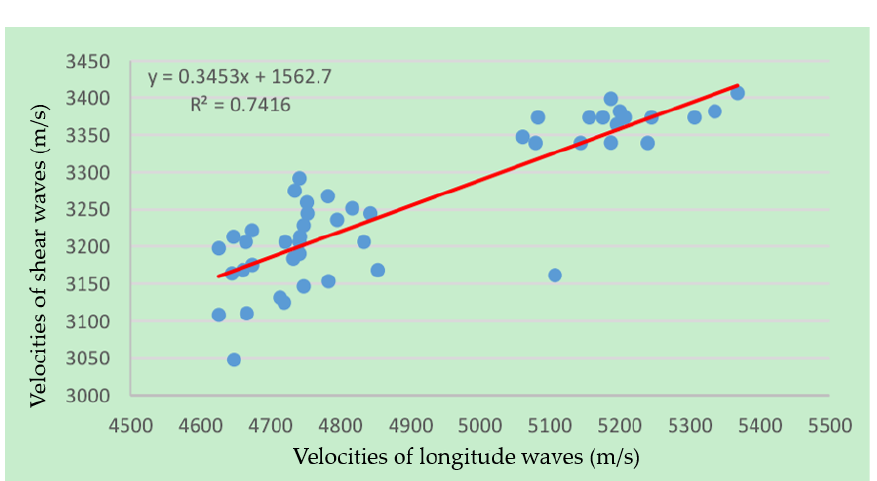
Figure 9. Measured velocities of the longitudinal and shear waves of the same testing point (blue dots) and their fit curve (red line).